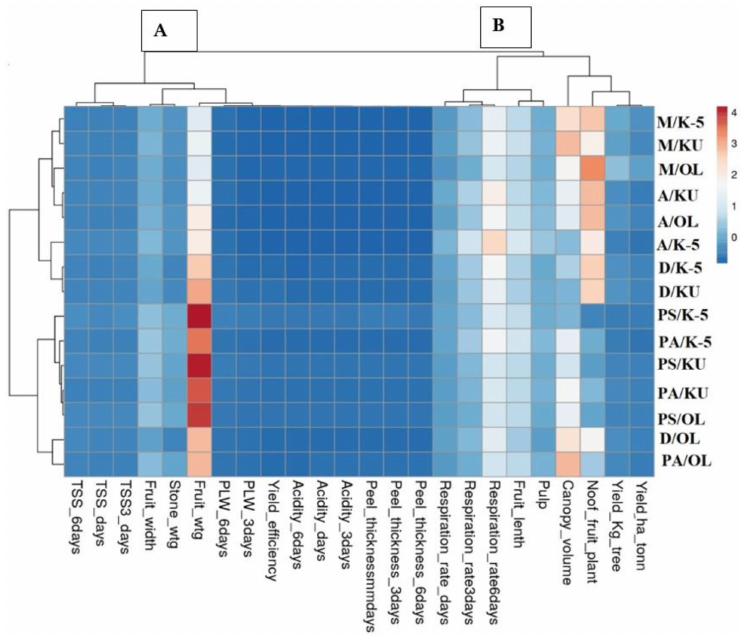
Figure 4. Heatmap and hierarchical clustering for fruit quality traits of scion/rootstock combinations in mango varieties: PA; Pusa Arunima, PS; Pusa Surya, A; Amrapali, D; Dashehari, M; Mallika, OL; Olour, KU; Kurukkan, K-5. Subgroup A and B represent distinct cluster of fruit quality traits based on expression and hierarchical